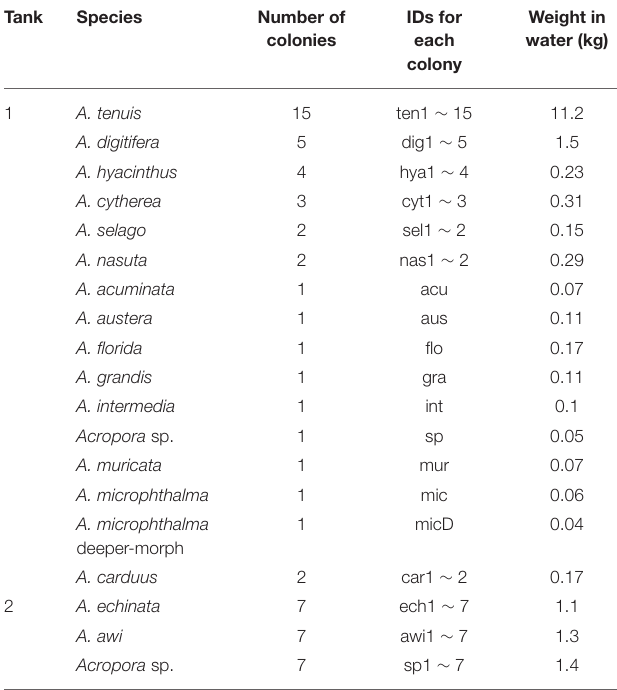
TABLE 1 | Acropora corals used in the study.